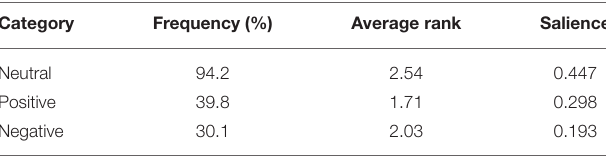
TABLE 2 | Frequency, average rank, and salience of beekeepers’ perception about giant armadillos ( Priodontes maximus ) through free-lists.